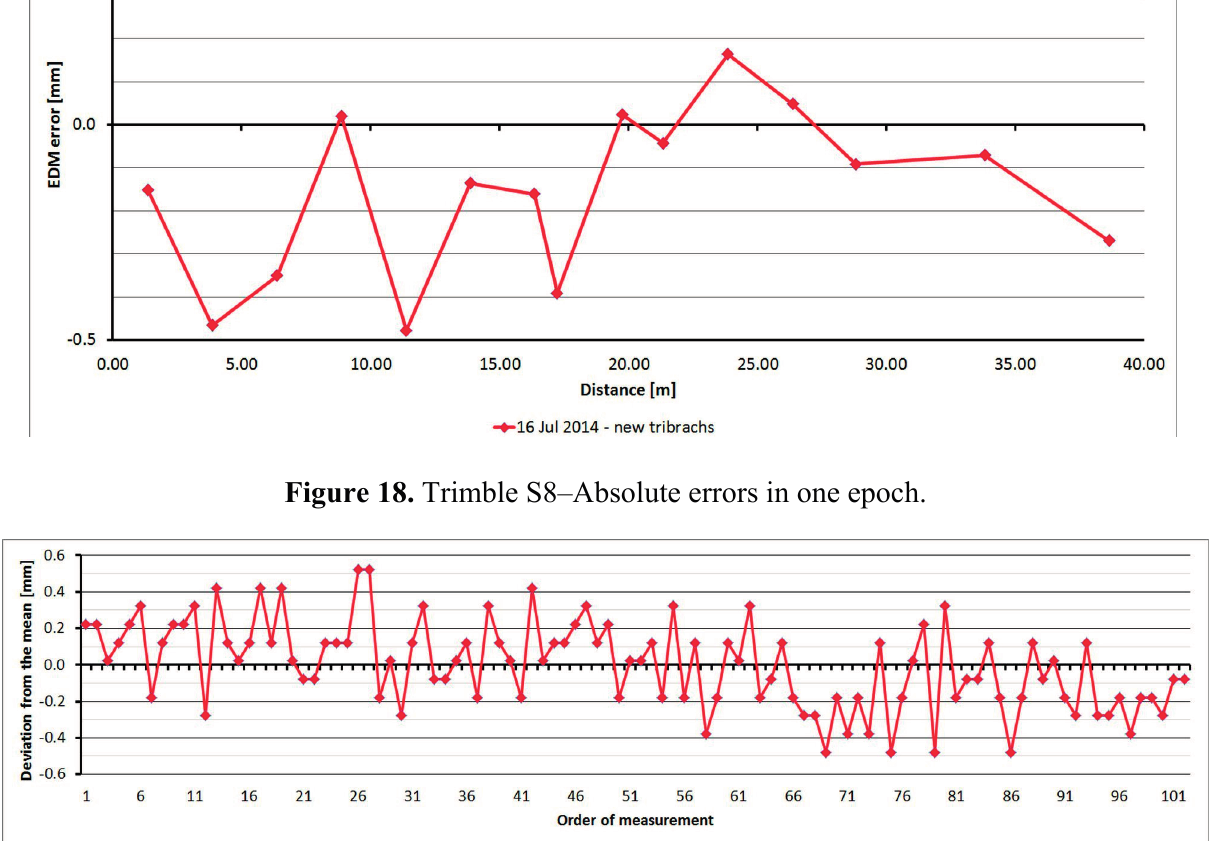
Figure 19. Trimble S8–Differences from average distance–pillar 7 (13.9